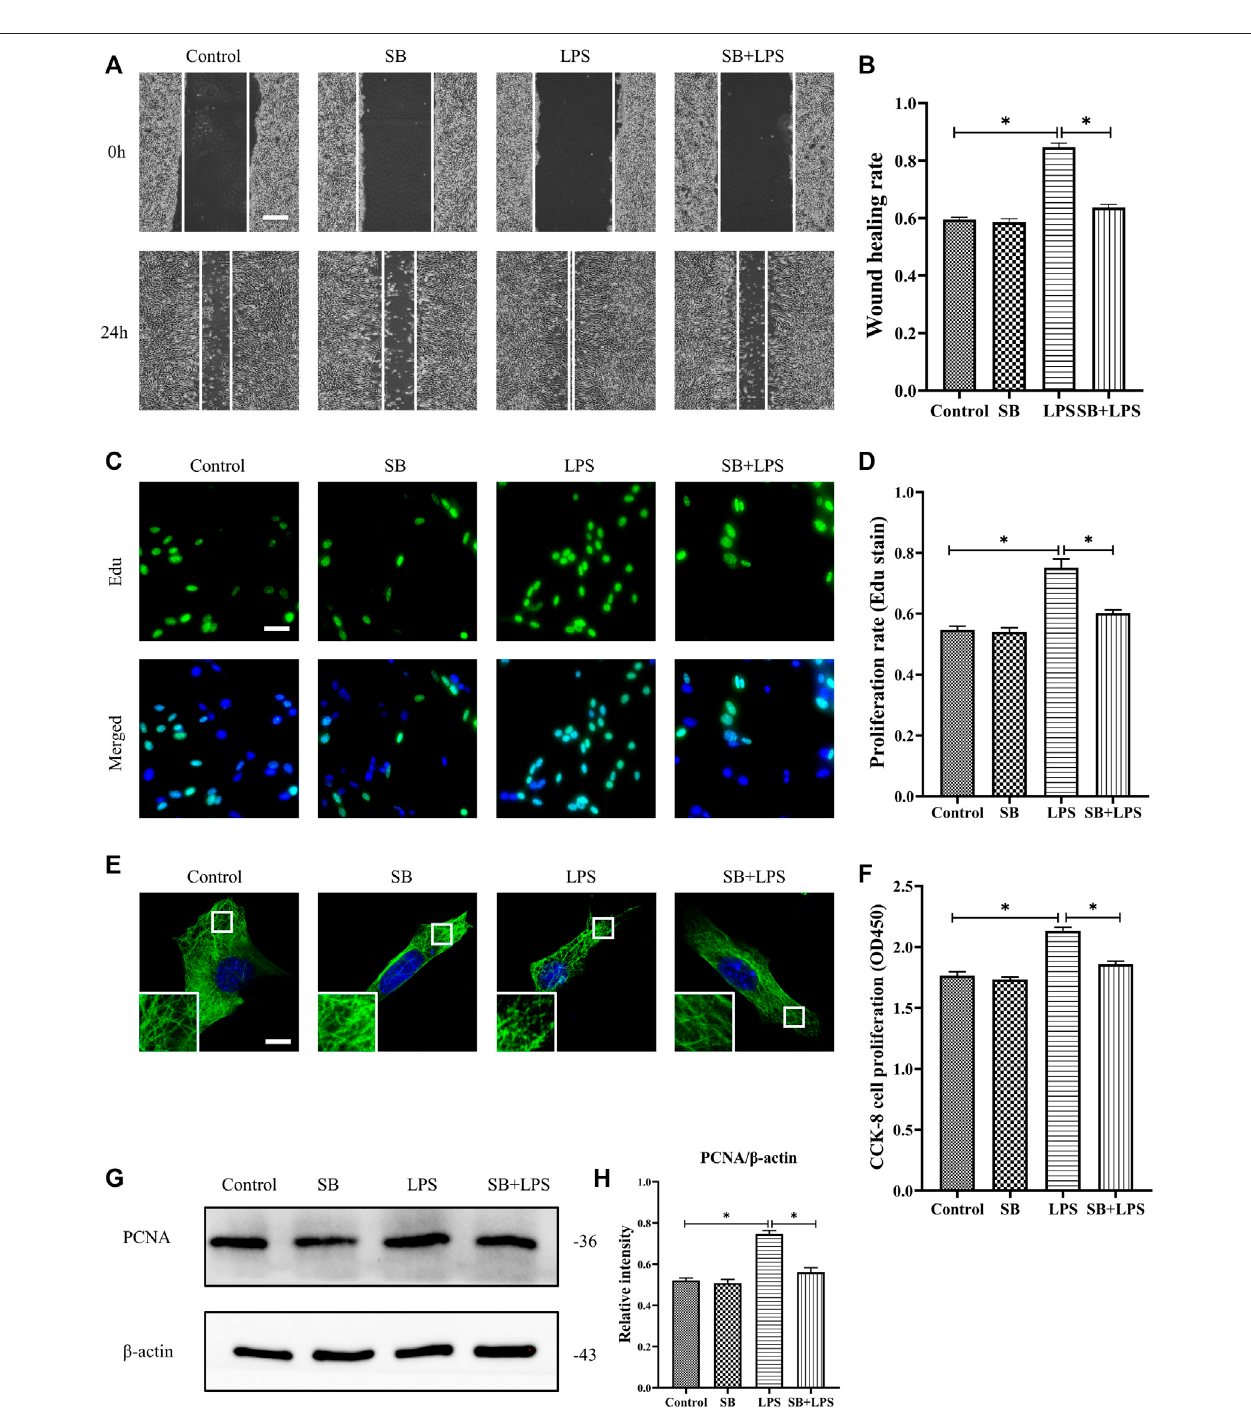
FIGURE 5 | Role of p38/MAPK activation in LPS-induced HDF migration and proliferation and MT depolymerization. (A) Scratch wound healing assays were performed to detect HDF migration treated with LPS with or without SB (5 µm) pretreatment. Bar, 200 μ m, and (B) the results were quantitatively analyzed ( n (cid:1) 5). (C) HDF proliferationwasdetected after LPStreatmentwithor withoutSBpretreatmentbyEdustaining,and (D) theresultswerequantitatively analyzed ( n (cid:1) 5). Nuclei were stained with Hoechst 33342. The merged image is to show the proportion of proliferating cells (green) to total cells (blue). Bar, 20 µm. (E) For the tubulin immuno fl uorescence images of MTs, cells were pretreated with SB before LPS treatment. These inserts show high-magni fi cation images of the peripheral MT network. Bar,10 µm. (F) HDFwassubjectedtoLPStreatmentwithorwithoutSBpretreatmenttodetectcellproliferationusingtheCCK-8assay( n (cid:1) 10). (G) Westernblottingwas performed to detect PCNA expression after LPS treatment with or without SB, and (H) the results were quantitatively analyzed ( n (cid:1) 5). The data are represented as the mean ± SEM. * p < 0.05 was considered to be signi fi cant.